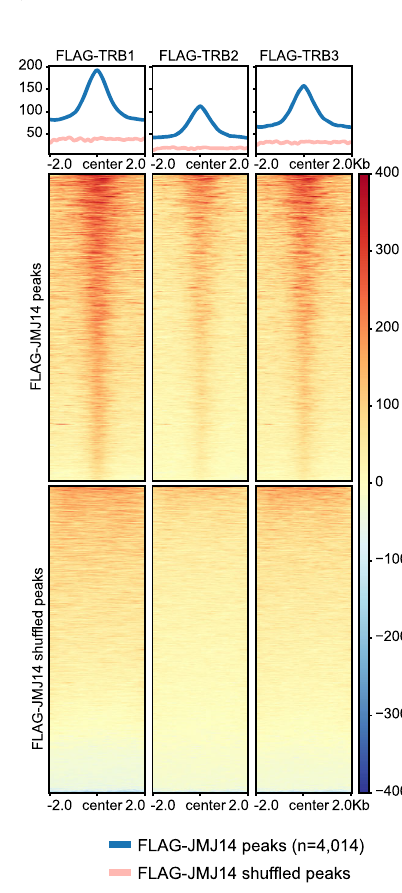
Fig. 1 | Arabidopsis TRBs interact with JMJ14. a Western blot showing a Co- immunoprecipitation (Co-IP) assay in Myc-JMJ14 F2 crossed lines with FLAG-TRB3, FLAG-TRB2, and FLAG-TRB1, respectively. Similar results were observed in two biological replicates. b Screenshots showing normalized ChIP-seq signals in FLAG-